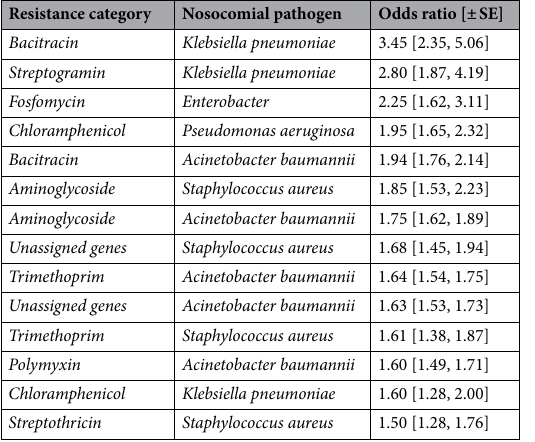
Table 2. Association of AMR signature classes with nosocomial pathogen detection in wound samples. Logistic regression models were constructed for classes of antimicrobial resistance genes detected via targeted sequencing in wound samples. The observed effects for resistance are shown, odds ratio > 1.5.